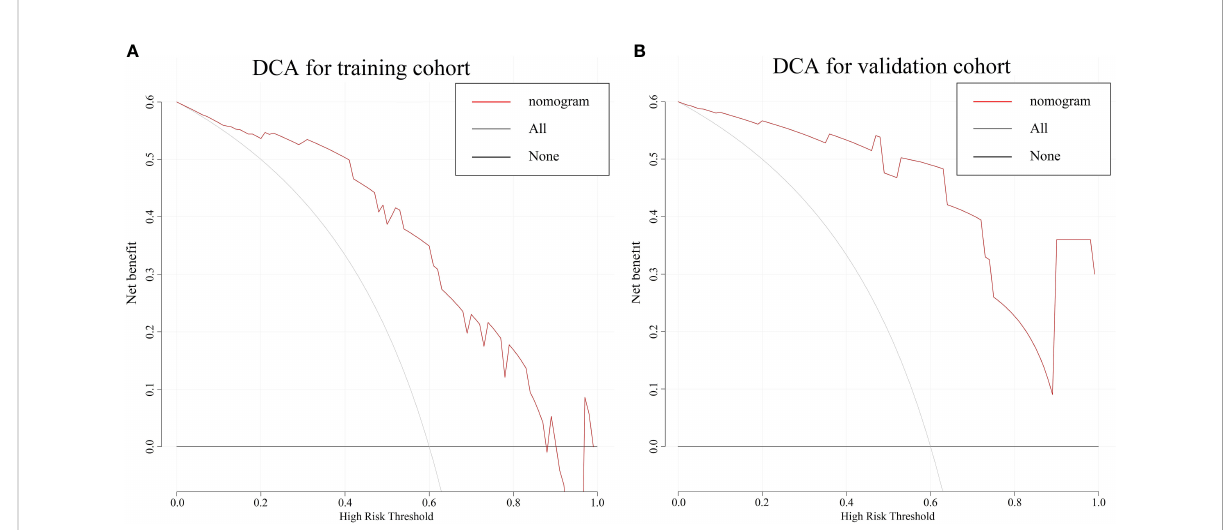
FIGURE 6 The DCA for the combine nomogram in the training cohort (A) and validation cohort (B) . The y-axis represents the net bene fi t. The x-axis represents the threshold probability. The red line represents the radiomics nomogram. The grey line represents the hypothesis that all patients had BES. The black line represents the hypothesis that no patients had BES. The DCA in two cohorts showed the nomogram had clinical bene fi t. DCA, Decision curve analysis; BES, benign esophageal